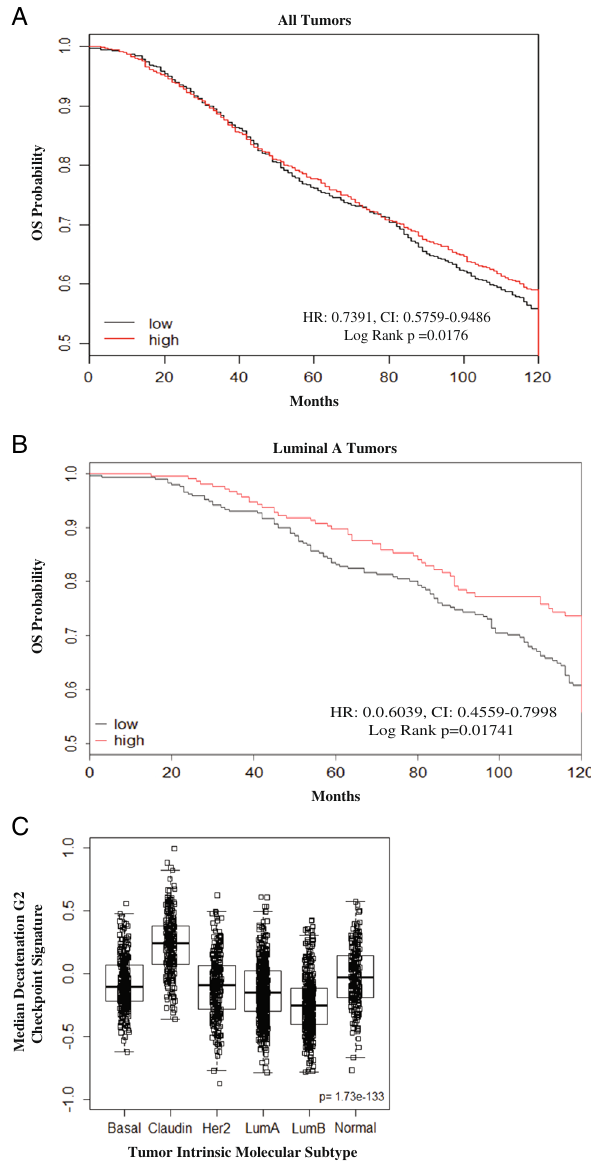
Fig. 5 A decatenation G 2 checkpoint gene expression signature correlates with clinical outcomes of breast cancer patients. a gene expression signature that positively correlated with decatenation G 2 checkpoint function in the breast cancer cell line panel was identi fi ed and its relationship with clinical outcomes in the METABRIC study was assessed using a Cox proportional hazards model. A high expression of the decatenation G 2 checkpoint signature was associated with better overall survival (OS) in all breast tumors (log rank p = 0.0176). b For the LumA subtype of breast tumors, high expression of the decatenation G 2 checkpoint was associated with better OS outcomes (Log Rank p = 0.01741). c Median decatenation G 2 checkpoint signature varies with intrinsic molecular subtype; LumA and LumB breast tumors exhibited the lowest median expression of the decatenation G 2 checkpoint signature. HR: hazard ratio, OS: overall survival, CI: con fi dence The results of this study indicate that intrinsic subtypes are associated with unique combinations of genomic instability patterns including aberrant cell cycle progression kinetics, chromosomal aberrations, and defective G 2 or M checkpoints. The initial G 2 /M checkpoint screen revealed that the LumB class